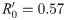
Surveillance data of the compartments for the disease free equilibrium.The reproduction number of the original strain is R0 = 0.8, while the reproduction number of the emergent strain is R0′=0.57. The vaccination rate used is 0.5.